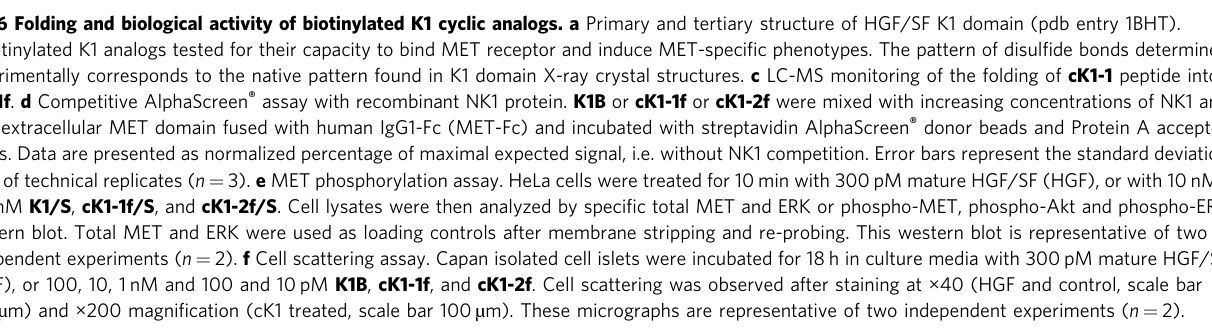
Fig. 6 Folding and biological activity of biotinylated K1 cyclic analogs. a Primary and tertiary structure of HGF/SF K1 domain (pdb entry 1BHT). b Biotinylated K1 analogs tested for their capacity to bind MET receptor and induce MET-speci fi c phenotypes. The pattern of disul fi de bonds determined experimentally corresponds to the native pattern found in K1 domain X-ray crystal structures. c LC-MS monitoring of the folding of cK1-1 peptide into cK1-1f . d Competitive AlphaScreen ® assay with recombinant NK1 protein. K1B or cK1-1f or cK1-2f were mixed with increasing concentrations of NK1 and with extracellular MET domain fused with human IgG1-Fc (MET-Fc) and incubated with streptavidin AlphaScreen ® donor beads and Protein A